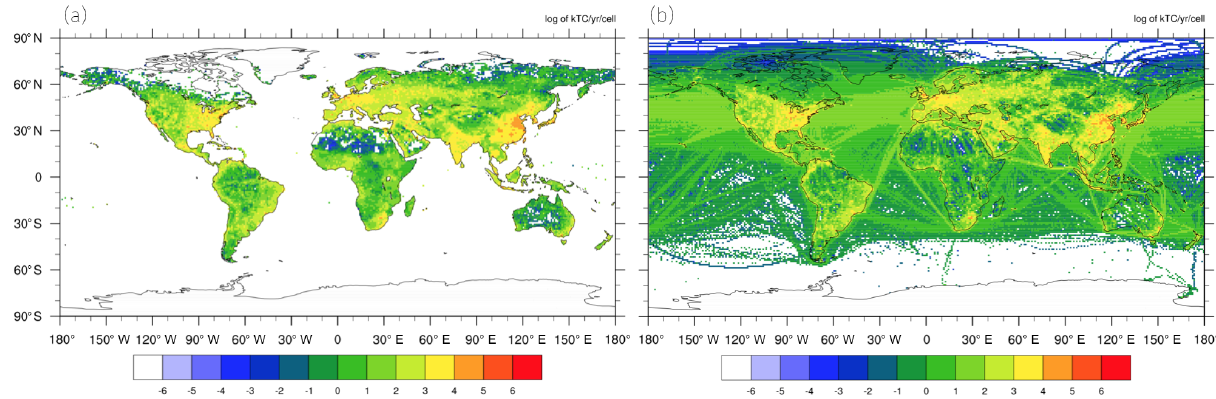
Figure 4. The 2013 global fossil fuel CO 2 emissions distributions from CDIAC ( a , 8.36PgC) and ODIAC ( b , 9.78PgC). The ODIAC emissions field was aggregated to a common 1 × 1 ◦ resolution. The value is given in the unit of log of thousand tons Ccell − 1 .